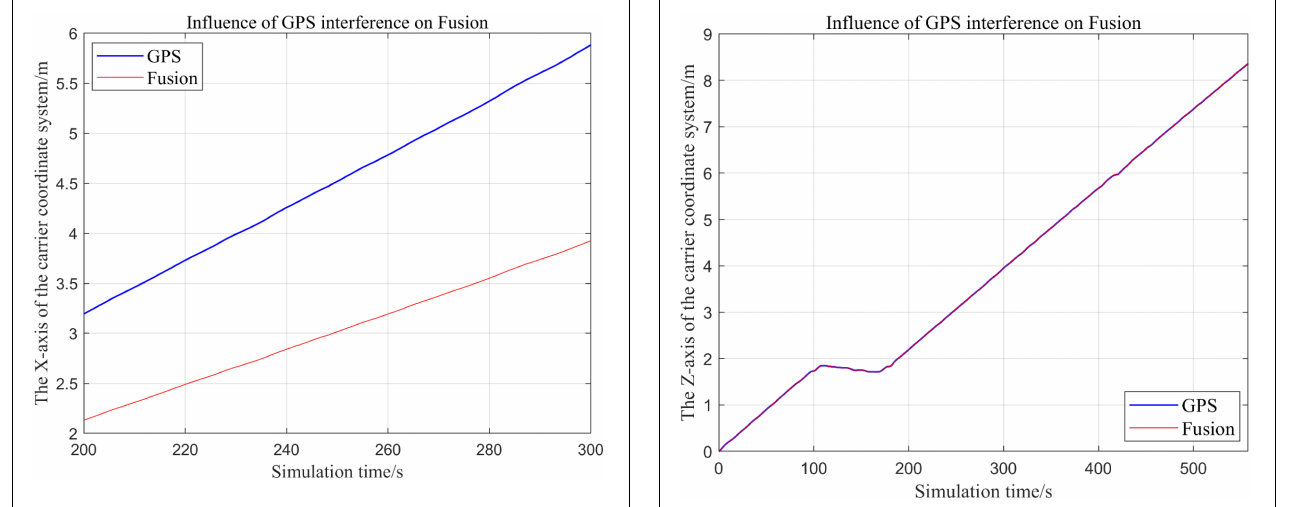
FIGURE 20 | Comparison of the local trajectory in x -axis after GPS failure and when all sensors are working normally.